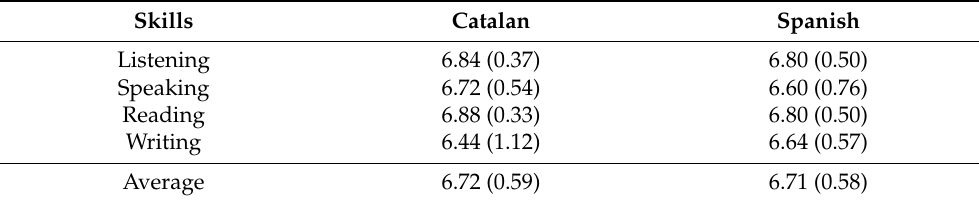
Table 4. Mean and standard deviation (in parentheses) of participants’ self-rated proficiency in Catalan and